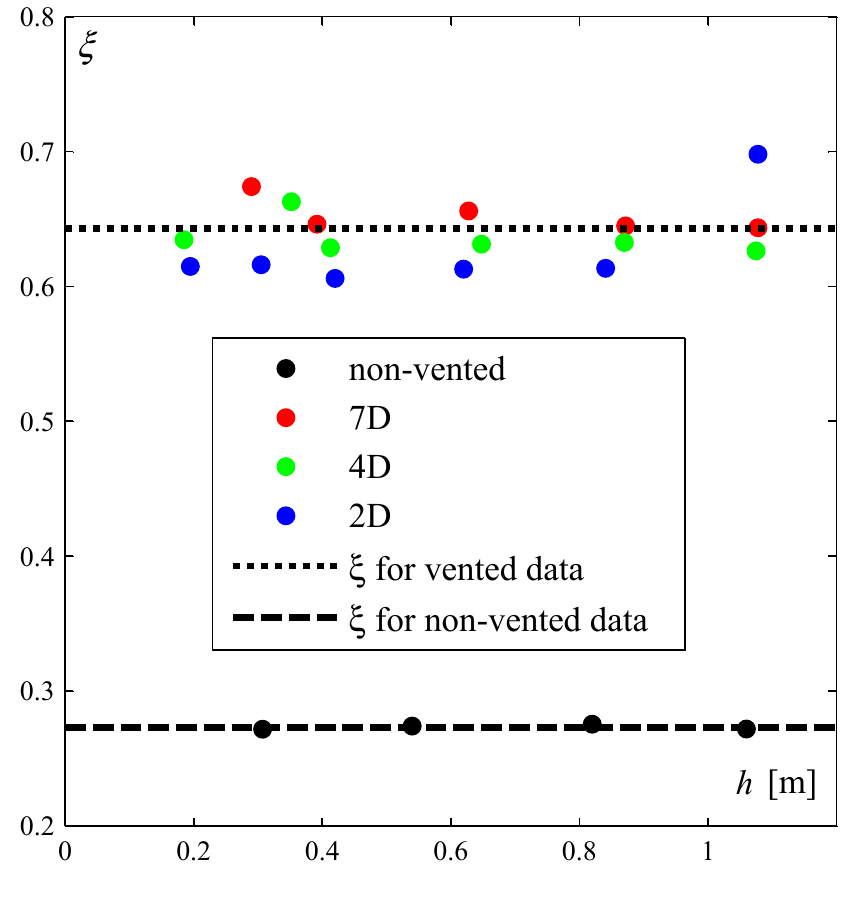
Figure 6. Local loss parameter, ξ , vs . water head, h